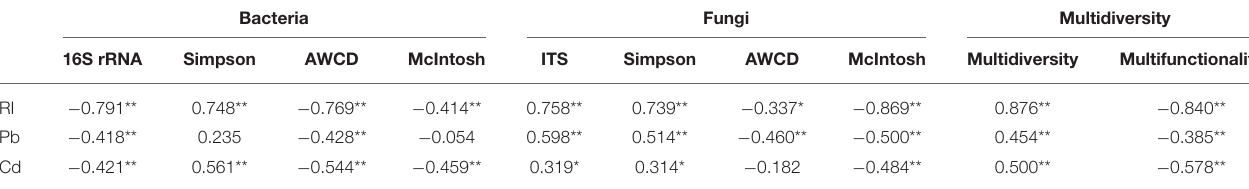
TABLE 1 | The correlation of RI , Pb and Cd content with microbial abundance and diversity. Bacteria Fungi Multidiversity 16S rRNA Simpson AWCD McIntosh ITS Simpson AWCD McIntosh Multidiversity Multifunctionality RI − 0.791**